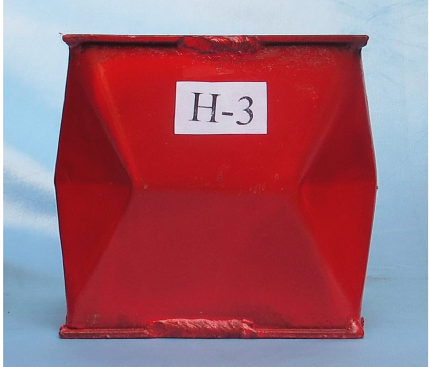
Figure 11: Single crash box.